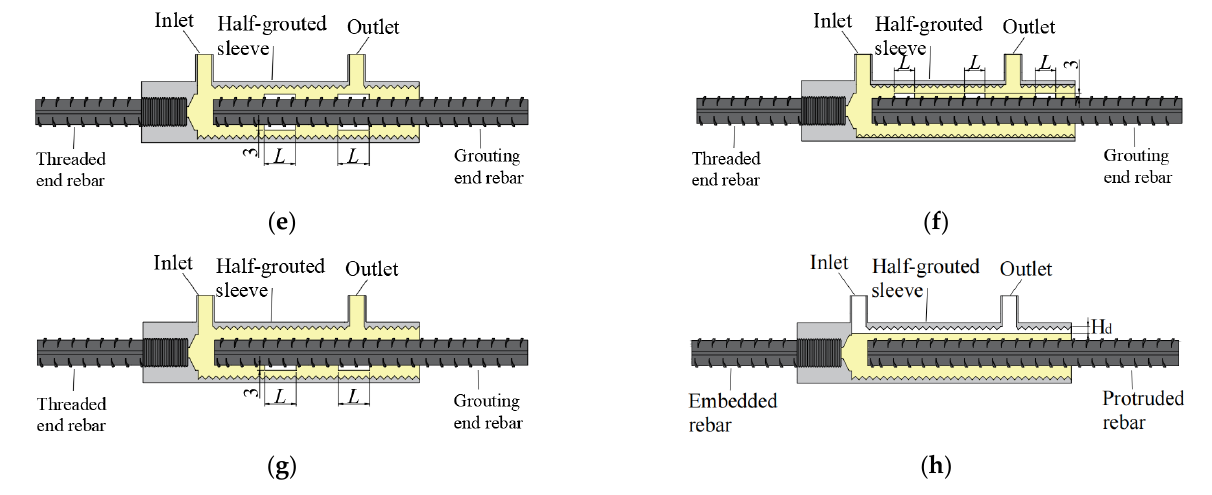
Figure 7. Details of the specimens. ( a ) GT14-BM. ( b ) GT14-DB. ( c ) GT14-ZB-2.5 d . ( d ) GT14-JB-3-2.5 d .